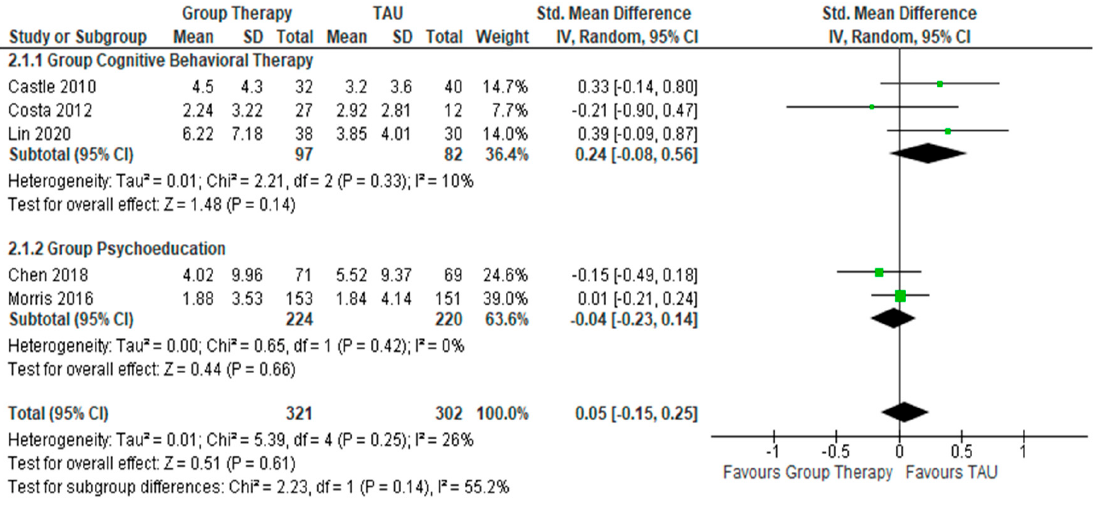
Figure 4. Forest Plots for the changes in severity of manic symptoms after interventions.